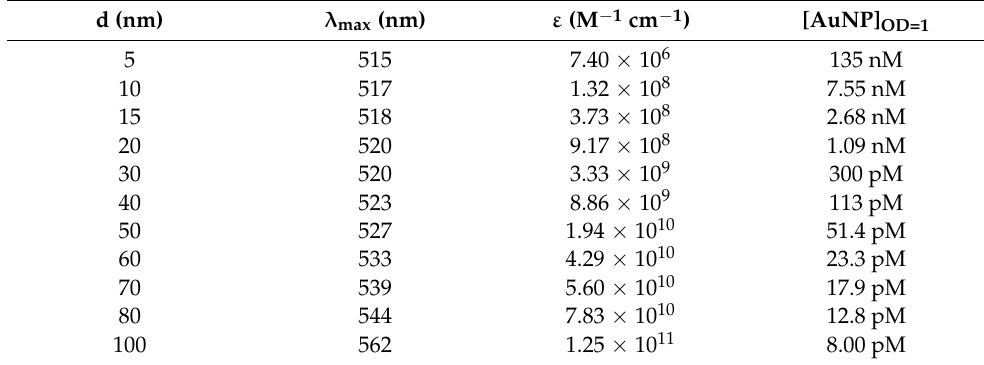
Table 1. Optical properties of the AuNP colloids from Figure 2. d, λ max , ε , and [AuNP] represent the diameter, extinction peak, extinction coefficient at the peak, and concentration required to achieve an extinction of 1 OD over a 1 cm path length, respectively. The values are calculated from the information on the product datasheets (nanoComposix, San Diego, CA, USA). d (nm) λ max